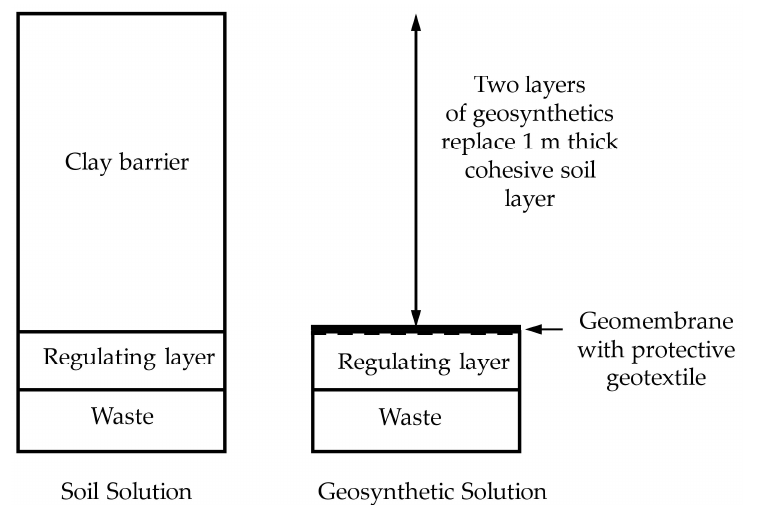
Figure 2. Scheme of the capping systems without/with geosynthetics, adapted from [42].